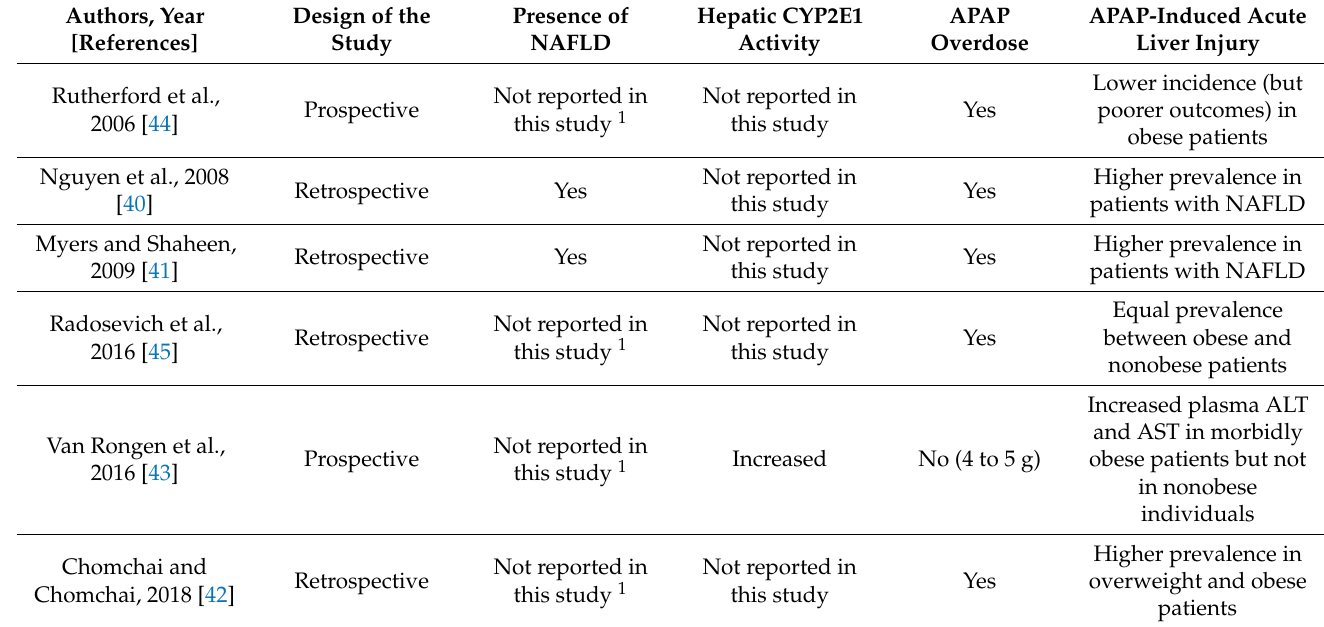
Table 1. Summary of the clinical studies (ordered by increasing year) carried out on APAP-induced acute liver injury in obesity and NAFLD.